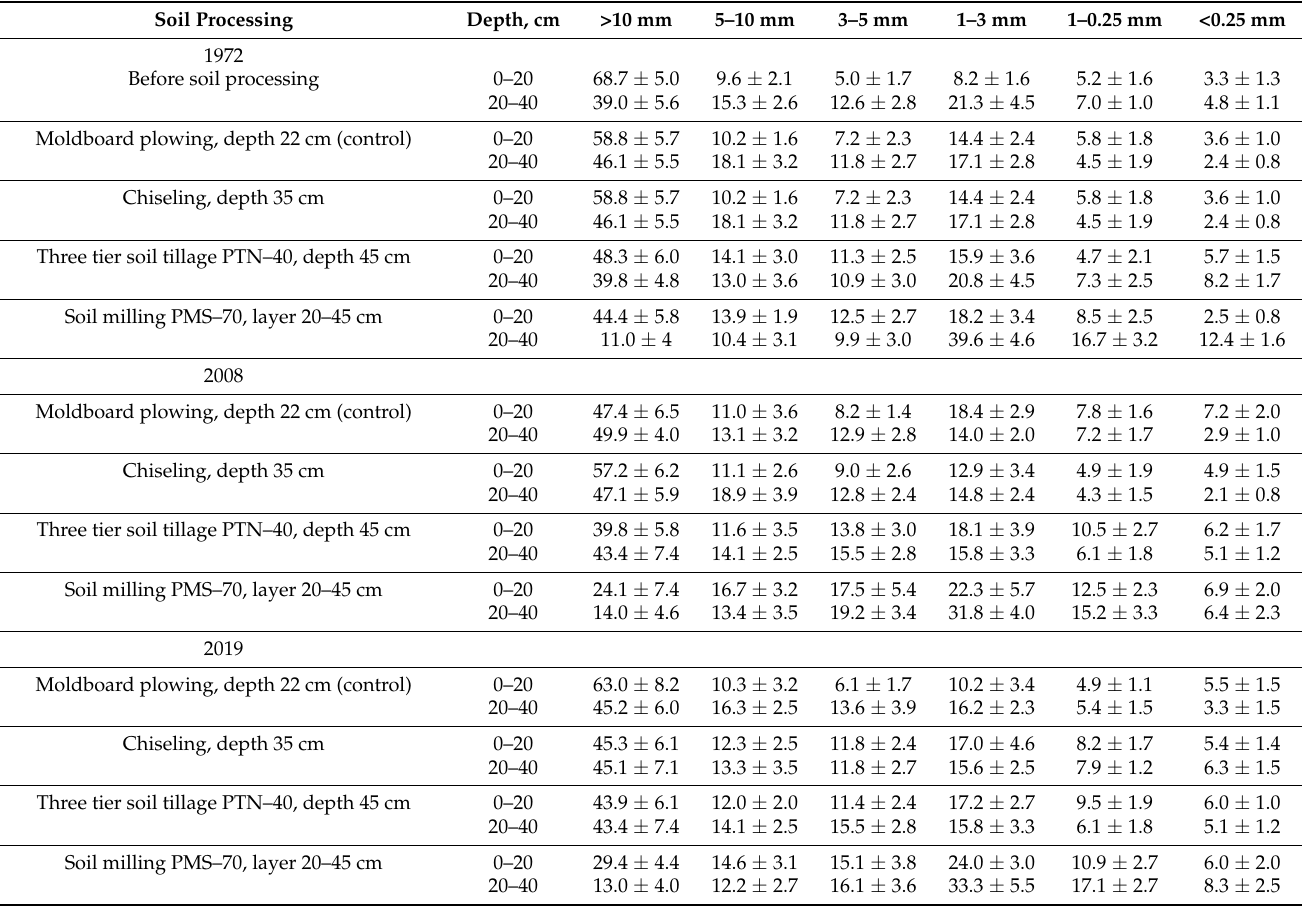
Table 3. Solonetz soil profile aggregate composition after soil mechanical treatment. Dry sieving fractions, %. Experimental site "Kolkhoz Leninsky Put’".